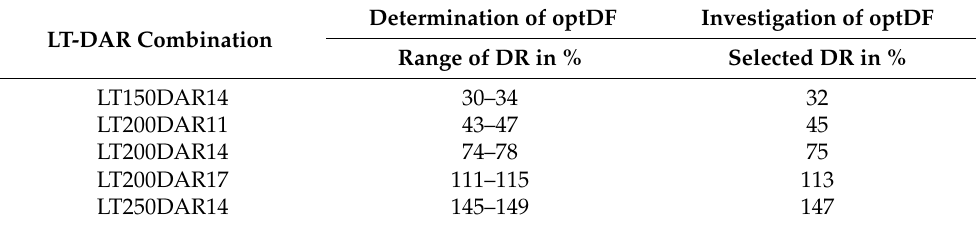
Table 2. For the determination and investigation of the optDF, specimens were manufactured according to the parameter sets in the table. Overview of the range of DR and the selected DR for the the five LT-DAR combinations from Table